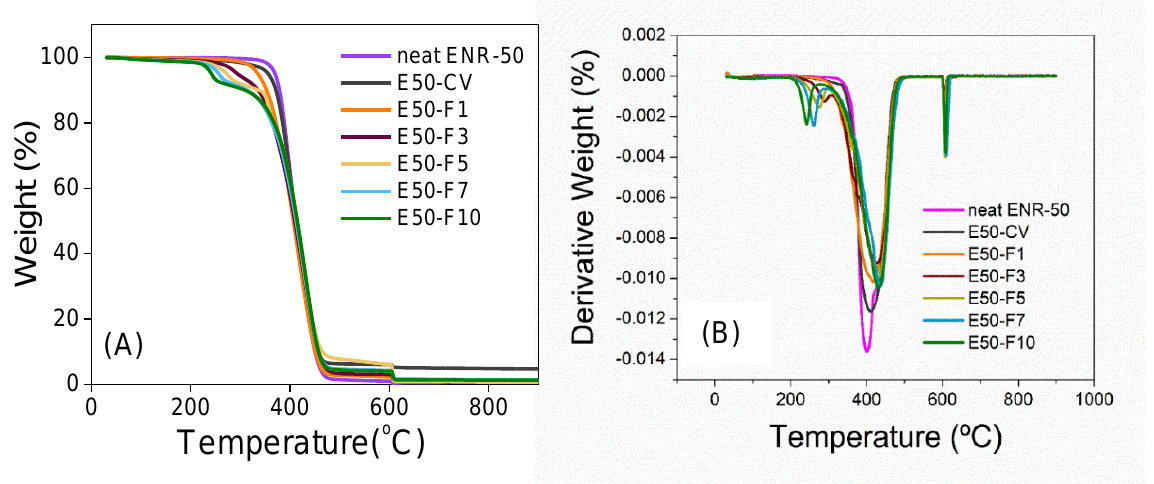
Figure 7. TGA ( A ) and DTG thermograms ( B ) of neat ENR-50 and ENR-50 compounded with various concentrations of FeCl3 at 1, 3, 5, 7 and 10 mmol the conventional sulfur vulcanization system (i.e., E50-CV).